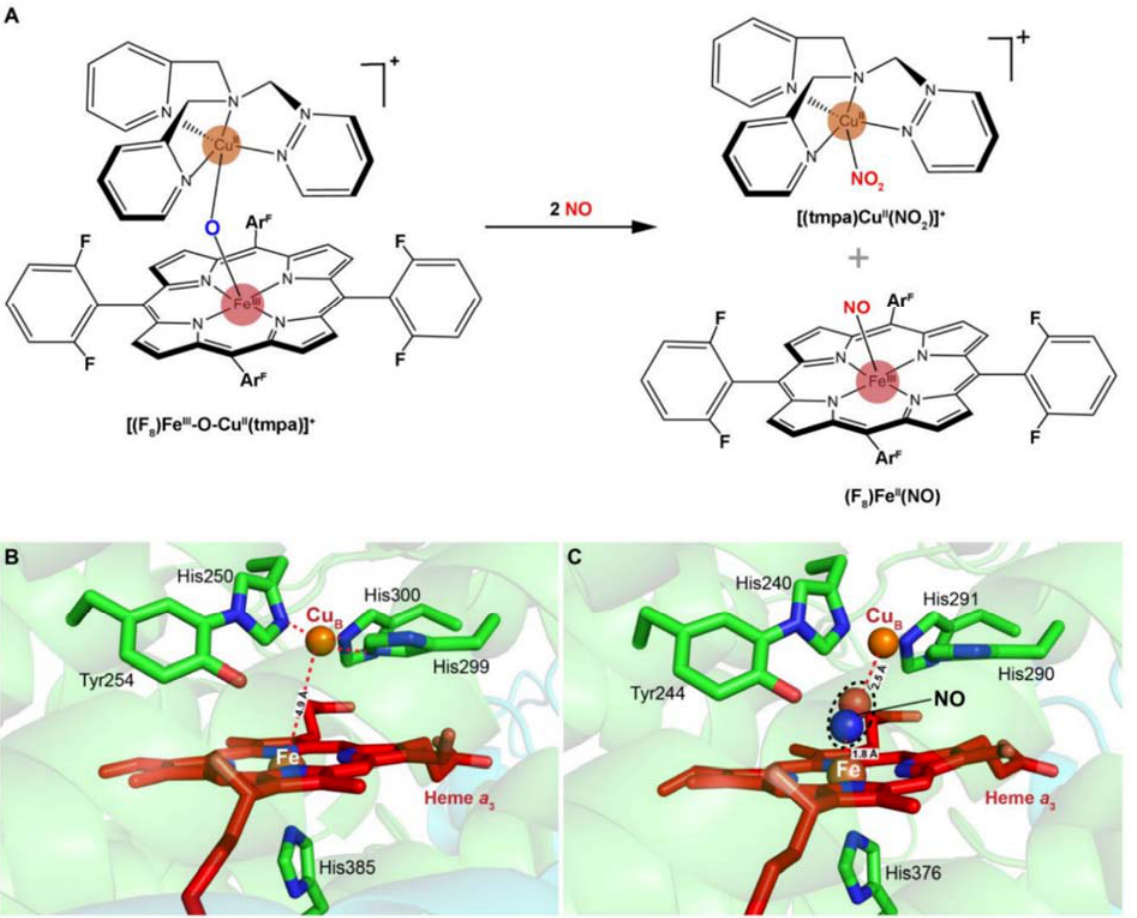
Figure 4. Scheme of a heme ‐ copper assembly mediated oxidation of NO to nitrite and structures of ligand ‐ absent and NO ‐ binding BNCs of CcOs. ( A ) A μ‐ oxo heme ‐ FeIII ‐ O ‐ CuII complex facilitates NO oxidation to nitrite, forming reduced heme and CuII ‐ nitrito complexes. This scheme is modified from the figure in reference [26] with ChemDraw. ( B ) Spatial structure of the BNC of Cyt caa3 oxidase from T. thermophilus HB8. The copper atom (CuB) is coordinated by three histidine residues. The distance between CuB and heme ‐ iron is less than 5 Å. ( C ) X ‐ ray structure of the NO ‐ bound CcO from bovine CcO. The distances between CuB and oxygen atom from NO, heme ‐ Fe, and nitrogen atom from NO are 2.5 Å and 1.8 Å, respectively. Figures of B and C are prepared with PyMOL (Molecular Graphics System, LLC) https://www.pymol.org (accessed on 20 December 2021).